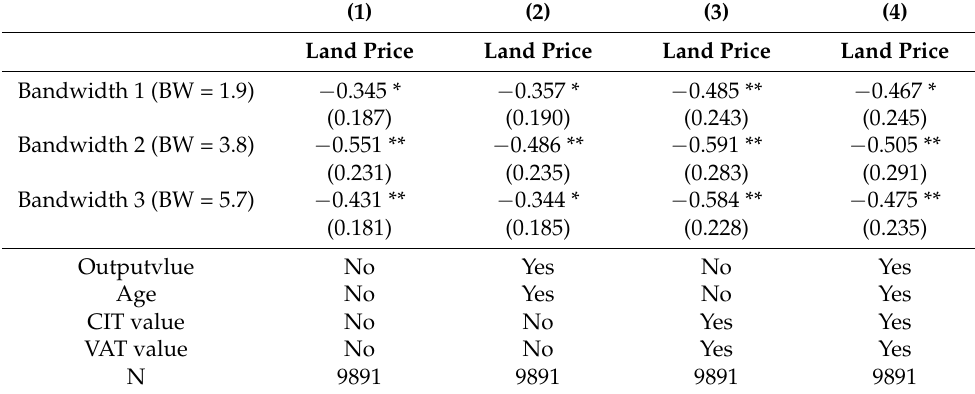
** and * here denote significance at the 5% and 10% confidential levels, respectively. "Yes" in the table indicates that we add the corresponding covariate.